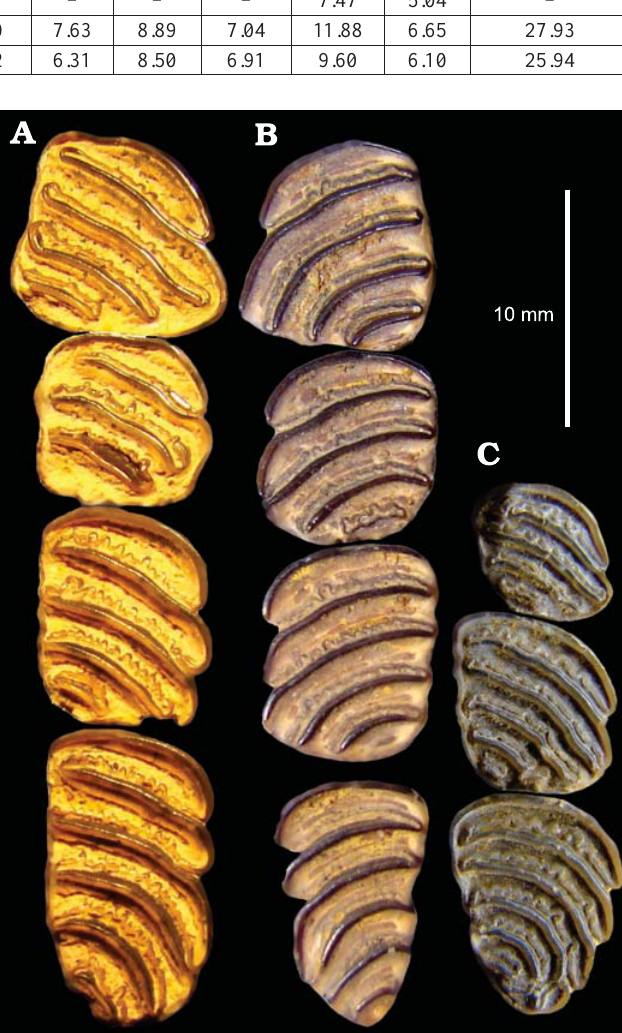
Table 2. Measurements (in mm) of the upper cheek teeth of potamarchines from the Solimões Formation and comparative specimens. LLW lin- guolabial width; MDL, mesiodistal length. Taxon/Specimen Pseudopotamarchus villanuevai UFAC 4762